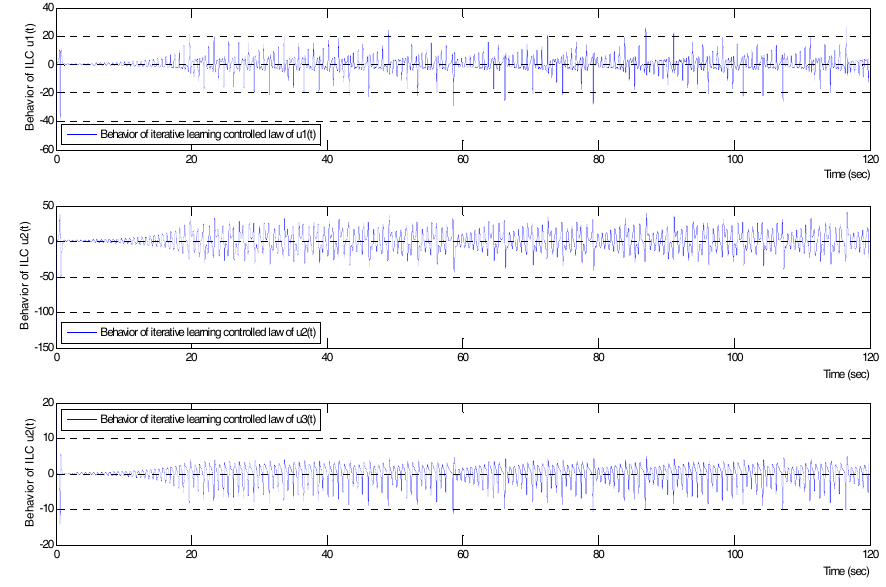
Figure 4. The behavior of the iterative learning control law.